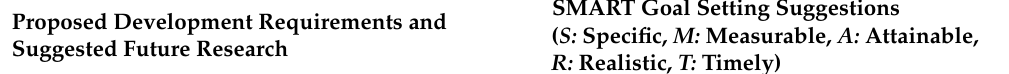
Table 2. Proposed research for developing the ReMINDS